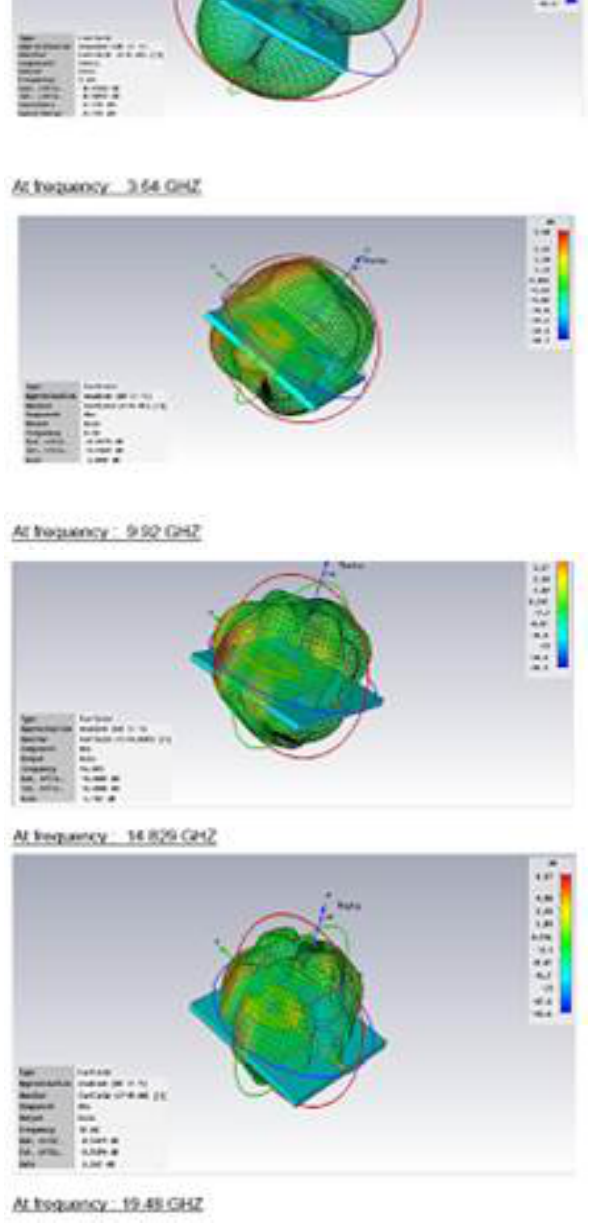
Figure 3: Radiation pattern on different frequencies.